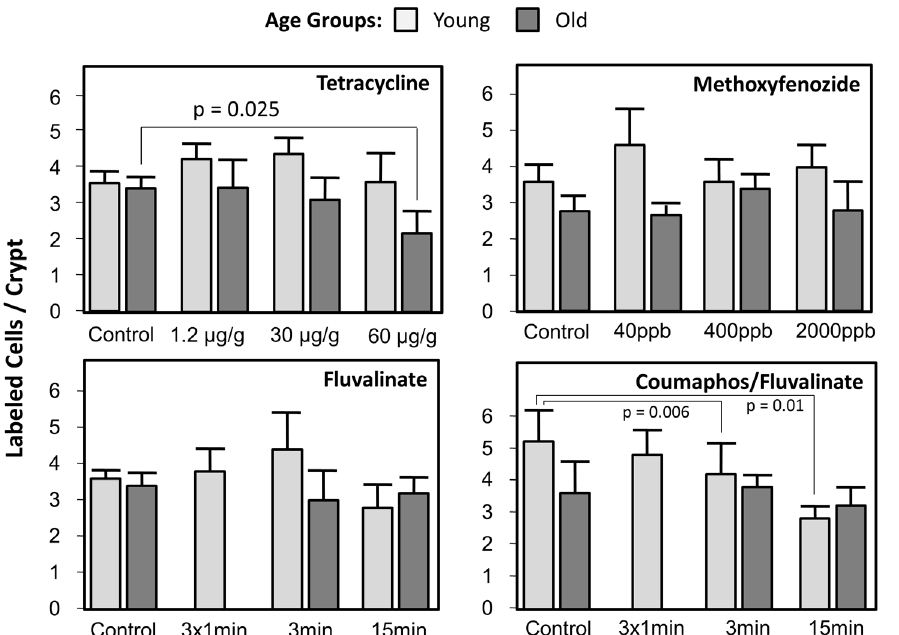
Figure 4. ISC proliferation, indicated by the number of BrdU-labeled nuclei per active crypt, was significantly decreased in older bees. The combination of coumaphos and fluvalinate reduced proliferation measured immediately after treatment, while tetracycline decreased proliferation only at older ages, over ten days after exposure to the xenobiotic had ended.